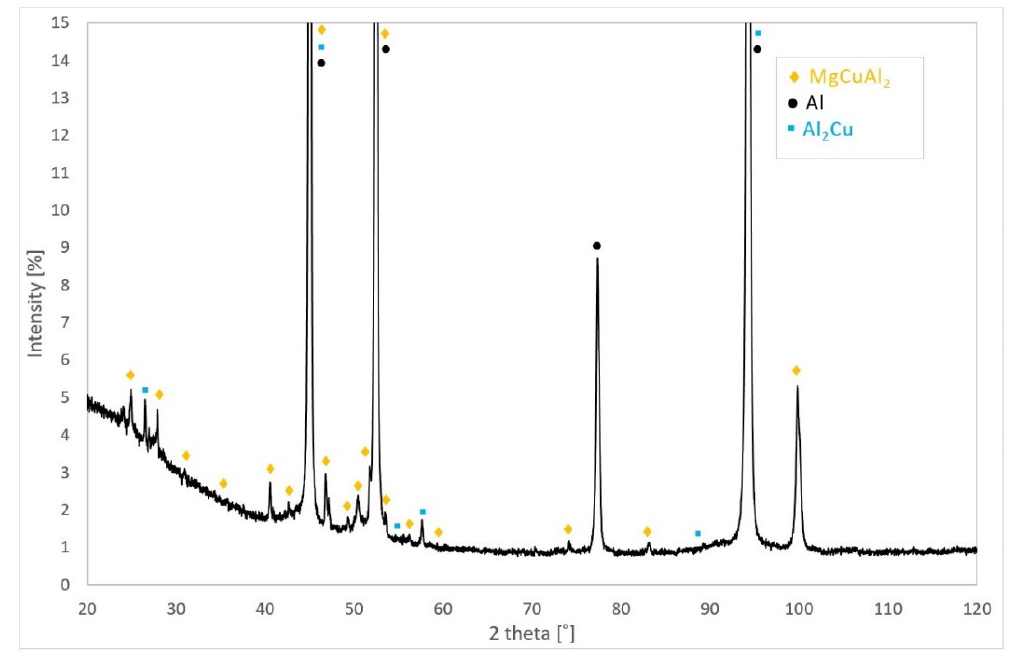
Figure 5. X-ray diffraction (XRD) phase analysis results for bare AW-2024-T3 in the initial state. Figure 5. X-ray di ff raction (XRD) phase analysis results for bare AW-2024-T3 in the initial